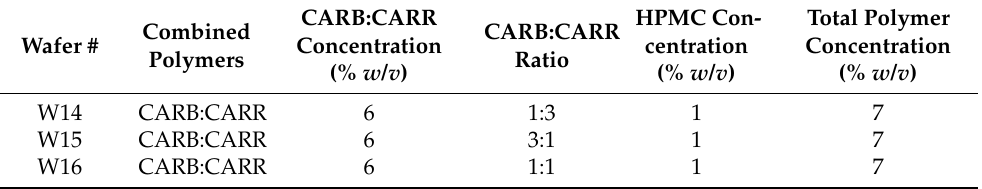
Table 2. Blank (BLK) composite CARB:CARR gels (6% w/v ) modified with HPMC showing different ratios of the polymers.